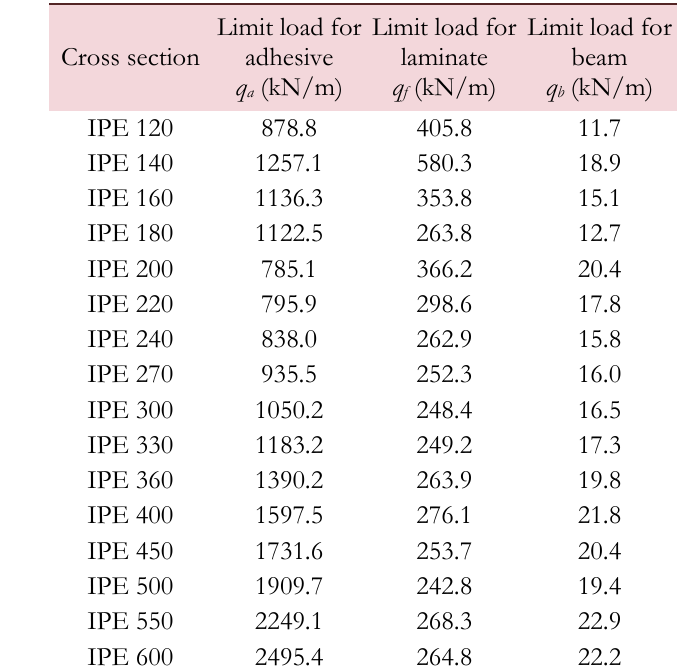
Table 4: Imposed loads at elastic limit states.